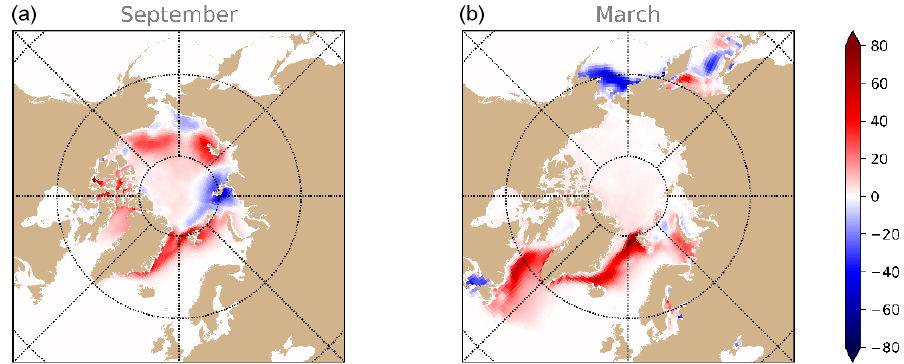
Figure 11. Difference in Arctic sea ice concentration in percent between the ensemble mean of EC-Earth3 and OSI SAF observations in September (a) and March (b) , averaged over 1980–2010.